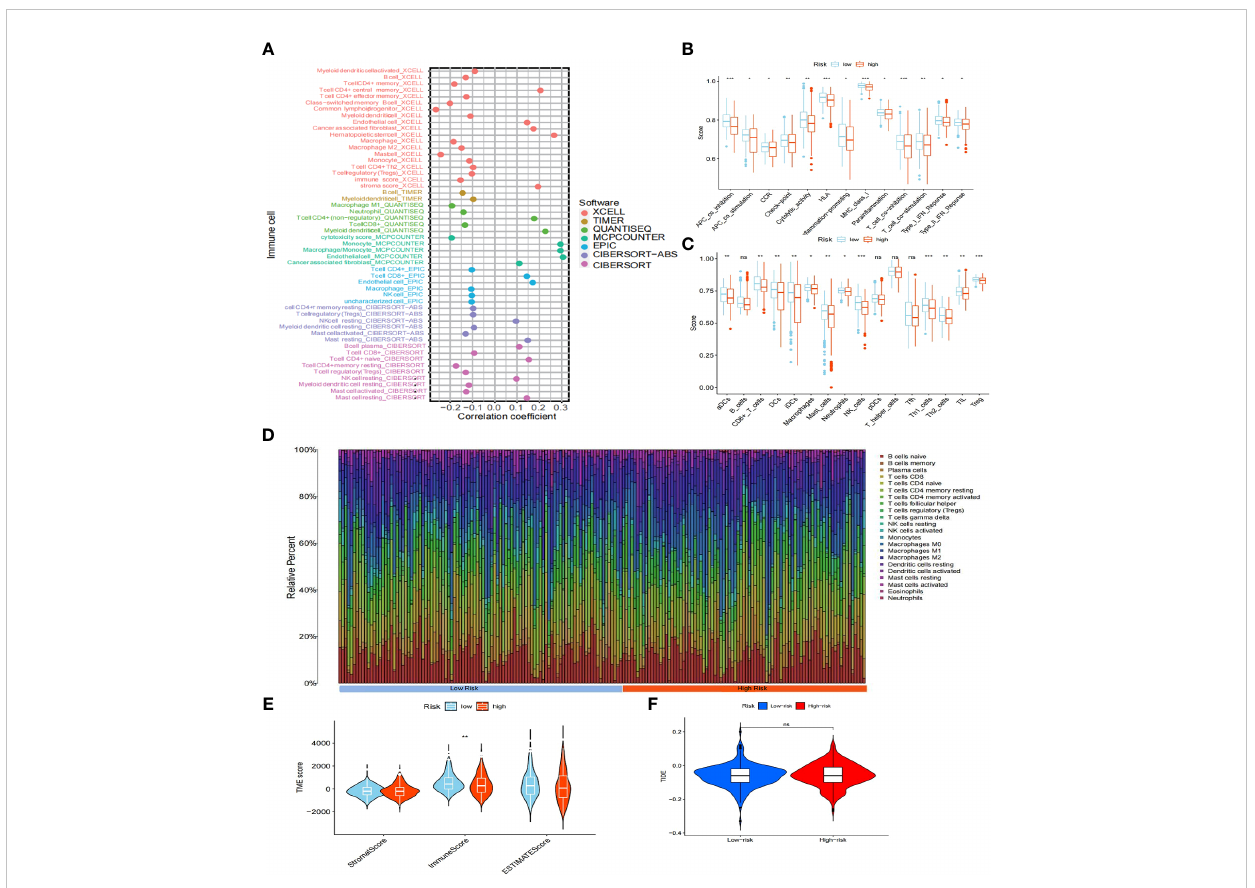
FIGURE 8 Immuno-in fi ltration analysis. (A) Association between risk scores and immune cells under seven algorithms (XCELL, TIMER, QUANTISEQ, MCPCOUNTER, EPIC, CIBERSORT-ABS, CIBERSORT). (B) Correlation between high- and low-risk groups and various immune functions in PTC and normal tissues. (C) Correlation between high- and low-risk groups and various immune cells in thyroid tumor and non-tumor tissues. (D) Distribution of cells in each sample in the high- and low-risk groups. (E) TME score for high- and low-risk groups. (F) TIDE score for high- and low- risk groups. "ns" means “ no signi fi cance ” *P<0.05, **P<0.01, ***P<0.001, P<0.05 was considered signi fi